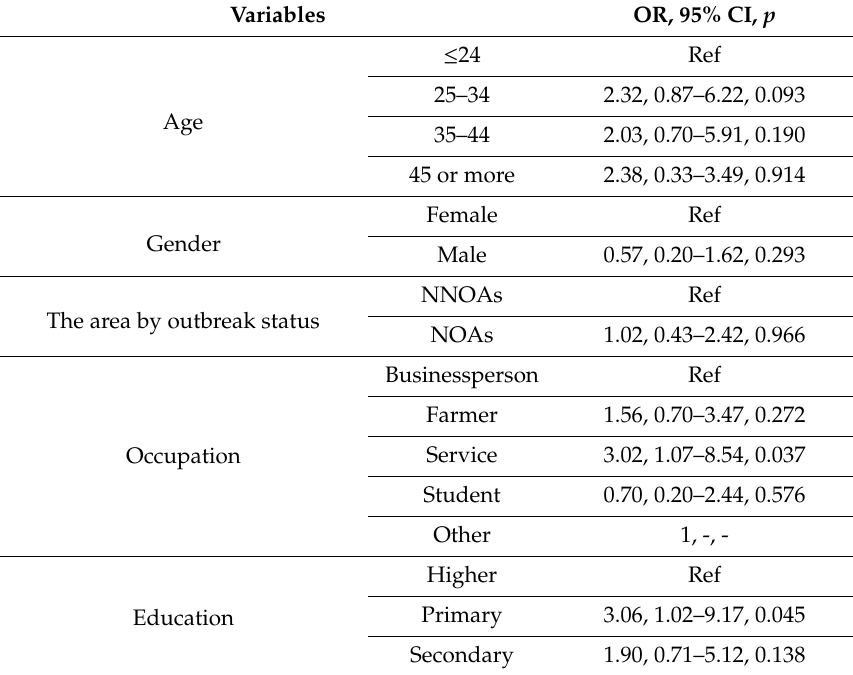
Table 7. Logistic regression analysis of the factors associated with respondents’ knowledge, attitudes, and perceptions of the spreading of